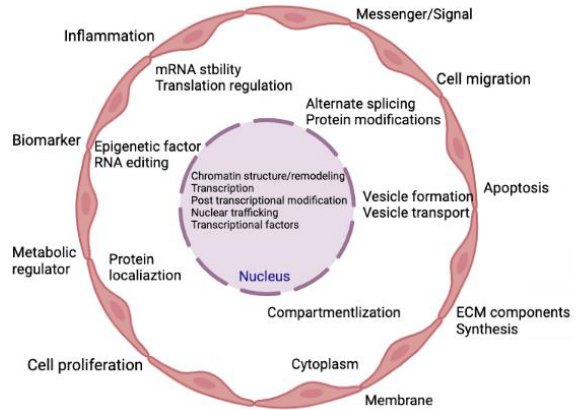
Figure 1. Summary of the cellular activities that are regulated by ncRNAs. Indeed, ncRNAs can directly and simultaneously modulate multiple targets and are involved in both gene expression and genome remodeling. Thus, ncRNAs control cellular functions directly or indirectly in both physiological and pathological conditions.